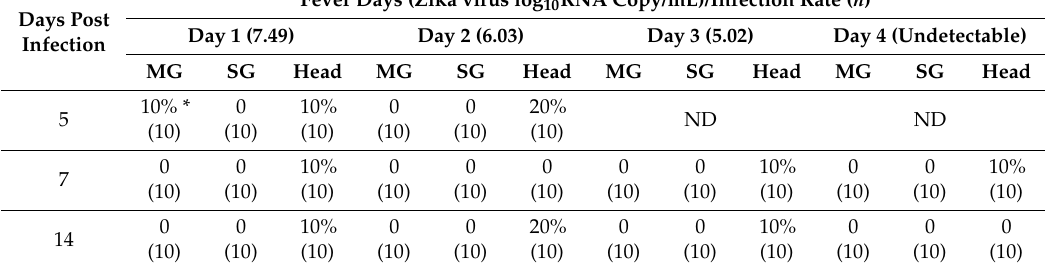
Table 1. Infection of Aedes aegypti (F2